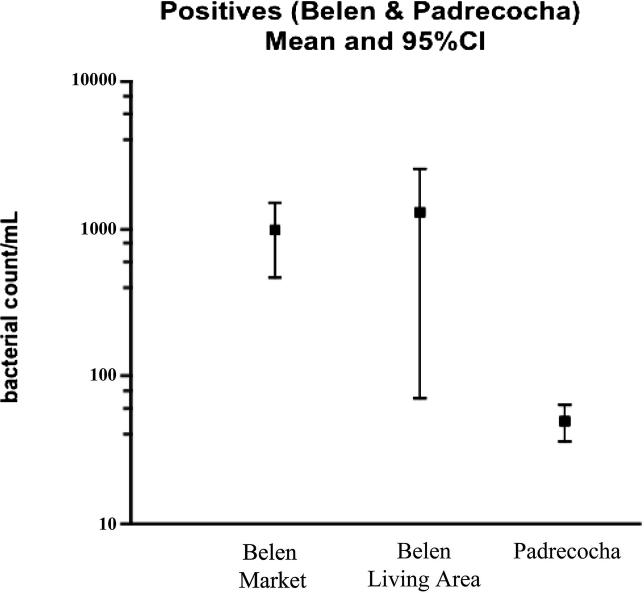
Quantification of Leptospira in Belen Versus PadrecochaBars indicate 95% confidence intervals. Analysis of variance, F = 8.406, p = 0.0003. Newman-Keuls multiple comparison test: Padrecocha versus Belen market, p < 0.001; Padrecocha versus Belen living area, p < 0.01; Belen market area versus Belen living area, p > 0.05.